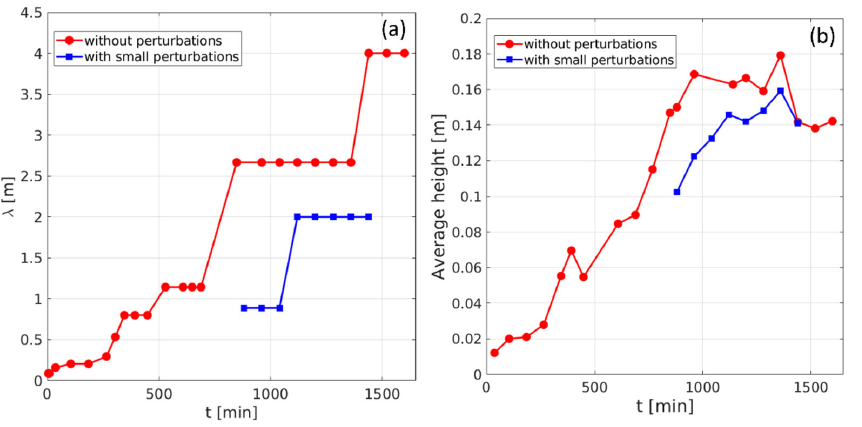
Figure 7. ( a ) Evolution of mean wavelength, with and without small perturbations applied after 880 min of simulations. ( b ) The mean height of the ripples as a function of time in minutes. After a linear growth stage, ripple height grows more slowly and time gaps between each change in the wavelength increases for the mature ripples.